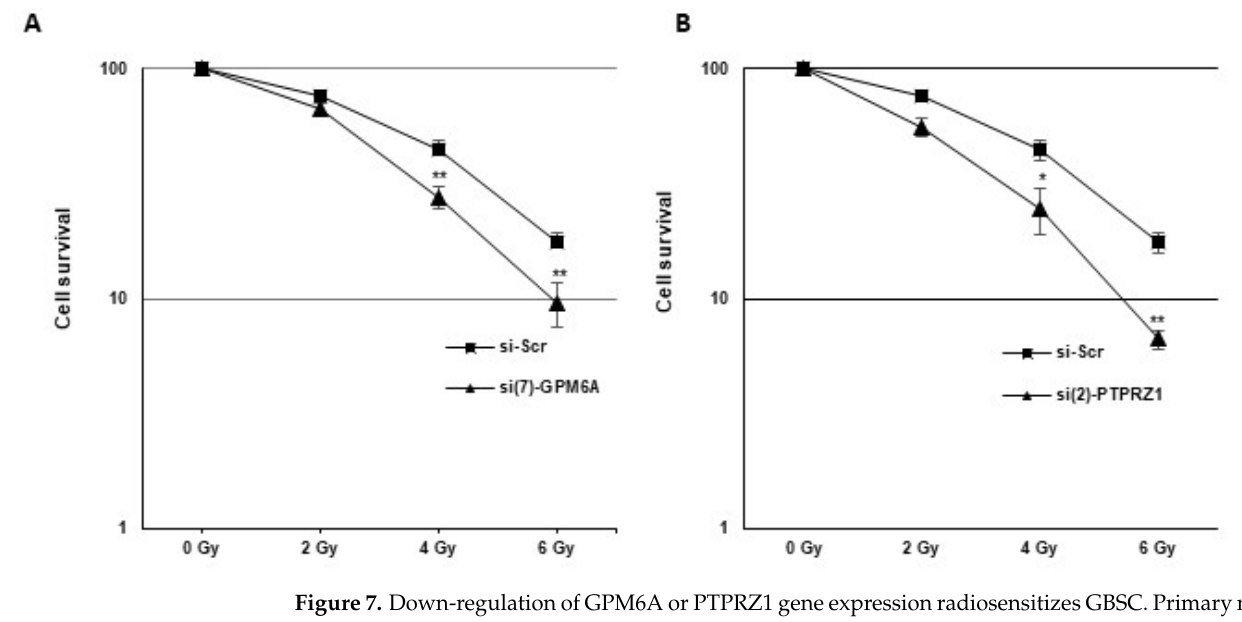
Figure 7. Down-regulation of GPM6A or PTPRZ1 gene expression radiosensitizes GBSC. Primary neurospheres (GSC02) expressing specific siRNAs ( A ) (si(7)-GPM6A or ( B ) si(2)-PTPRZ1) or a scramble control (si-Scr) were used in a 3D survival assays with increasing doses of IR (2 to 6 Gy) as described in the Methods. Quantifications of 3 experiments are presented as means ± SD. ** 0.001 < p < 0.01; * 0.01 < p < 0.05.